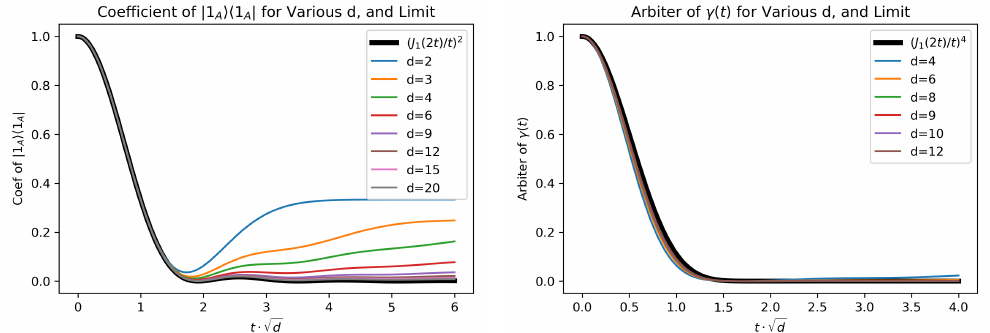
Figure 15: Simultaneous plot of the Figure 16: Simultaneous plot the ar- ( t ) 〉〉 for various first coefficient of 〈〈 ρ biter of 〈〈 γ ( t ) 〉〉 for various d against A d against scaled time. Also the limit to scaled time. Also the limit to which they which they converge, in black. converge, in